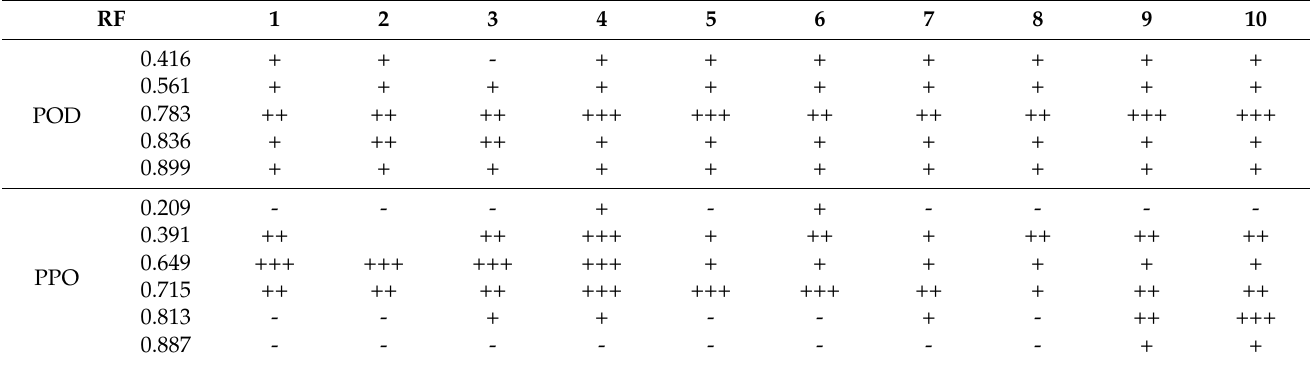
Figure 8. Effect of F. oxysporum and application of tested elicitors ( A. niger , A. flavus , P. oxalicum and M. circinelloides ) on PPO isozyme of tomato plants. Table 3. Isomers of POD and PPO and their retention factor (Rf) in response to F. oxysporum